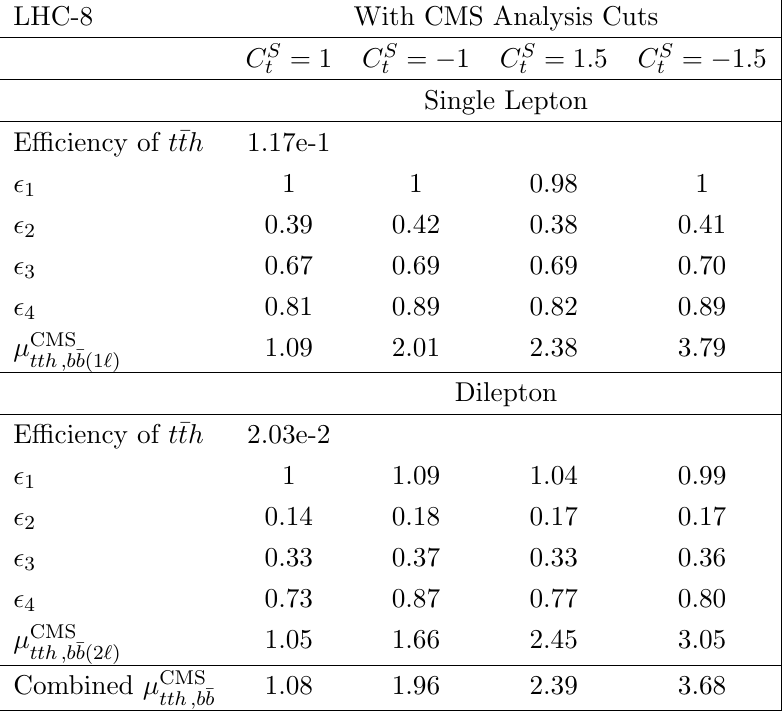
Table 9 . Category b (cid:22) b : the D -dependent detection e(cid:14)ciency ratios (cid:15) i ’s de(cid:12)ned in eq. (2.10) with p the CMS cuts for the category b (cid:22) b taking C S = (cid:6) 1 ; (cid:6) 1 : 5 and s = 8 TeV. The resulting signal t strengths (cid:22) CMS and (cid:22) CMS and the combined one (cid:22) CMS are also shown. tth;b (cid:22) b (1 ‘ ) tth;b (cid:22) b (2 ‘ ) tth;b (cid:22) b